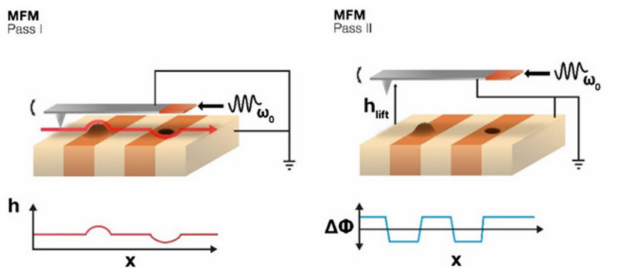
Figure 1. Standard MFM technique measuring the topography in the first pass ( left ) and the magne- tization in the second pass after lifting the tip ( right ). Reprinted from [5] with permission from AIP Publishing